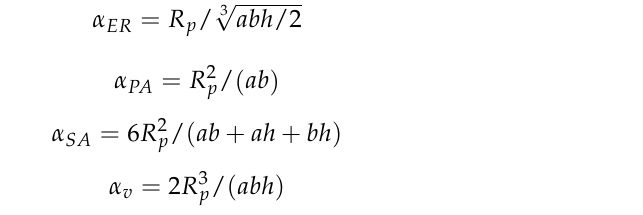
15 of 21 Figure 18. Wear distribution of samples for a scaling factor of 5. ( a ) Flat surface; ( b ) Convex pattern surface. To study the relation between the particle size and the dimensions of the convex, four